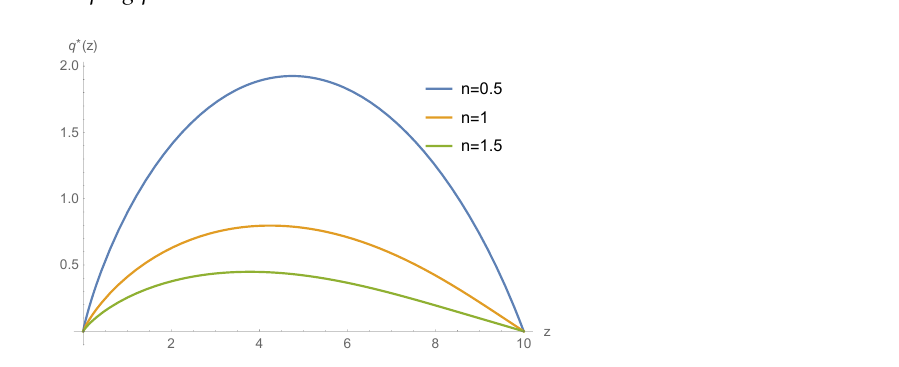
Figure 5. The optimal reinsurance policy with respect to z under di ff erent volatility rates n = 0.5,1,1.5.